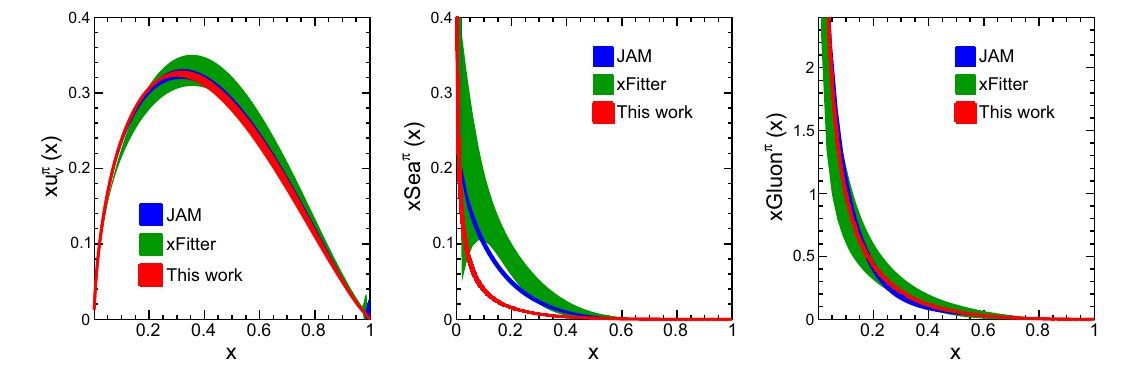
Fig. 10 Our obtained valence quark, sea quark, and gluon distributions of the pion compared with the recent analyses from JAM18 [33] and xFitter [35], at Q 2 = 20 GeV 2 . The error bands of this work show the 3 σ uncertainties of the quantities Table 2 Assuming PDFs obey ∝ ( 1 − x ) β in the large- x region approaching 1, we list the obtained values of the power β for valence quark, sea quark and gluon distributions of the pion and the kaon at Q 2 = 20 GeV 2 . The β values are extracted from the fits in the range of 0 . 6 < x < 1. The errors in the table indicate the 1 σ uncertainties